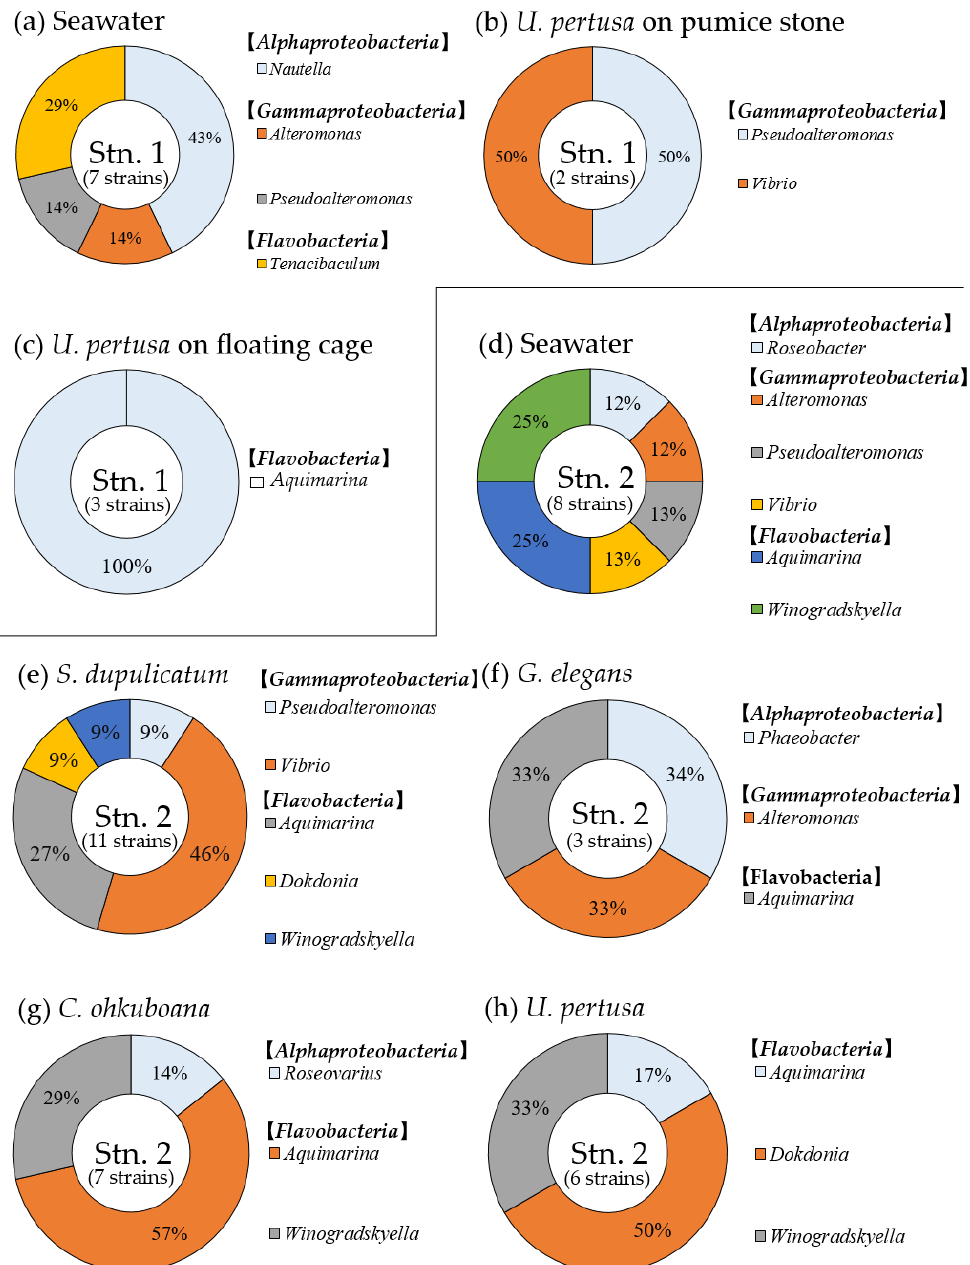
Figure 6. The composition of growth-limiting bacteria (class and genus) isolated from seawater and the different host macroalgae at Stn. 1 and 2. (Stn. 1: surface seawater ( a ), Ulva pertusa on pumice stone ( b ), U. pertusa on floating cage ( c ), Stn. 2: surface seawater ( d ), Sargassum dupulicatum ( e ), Gelidium elegans ( f ), Cladophora ohkuboana ( g ), U. pertusa ( h )).The number in parenthesis shows the number of strains used for 16S rRNA gene sequencing for identification.